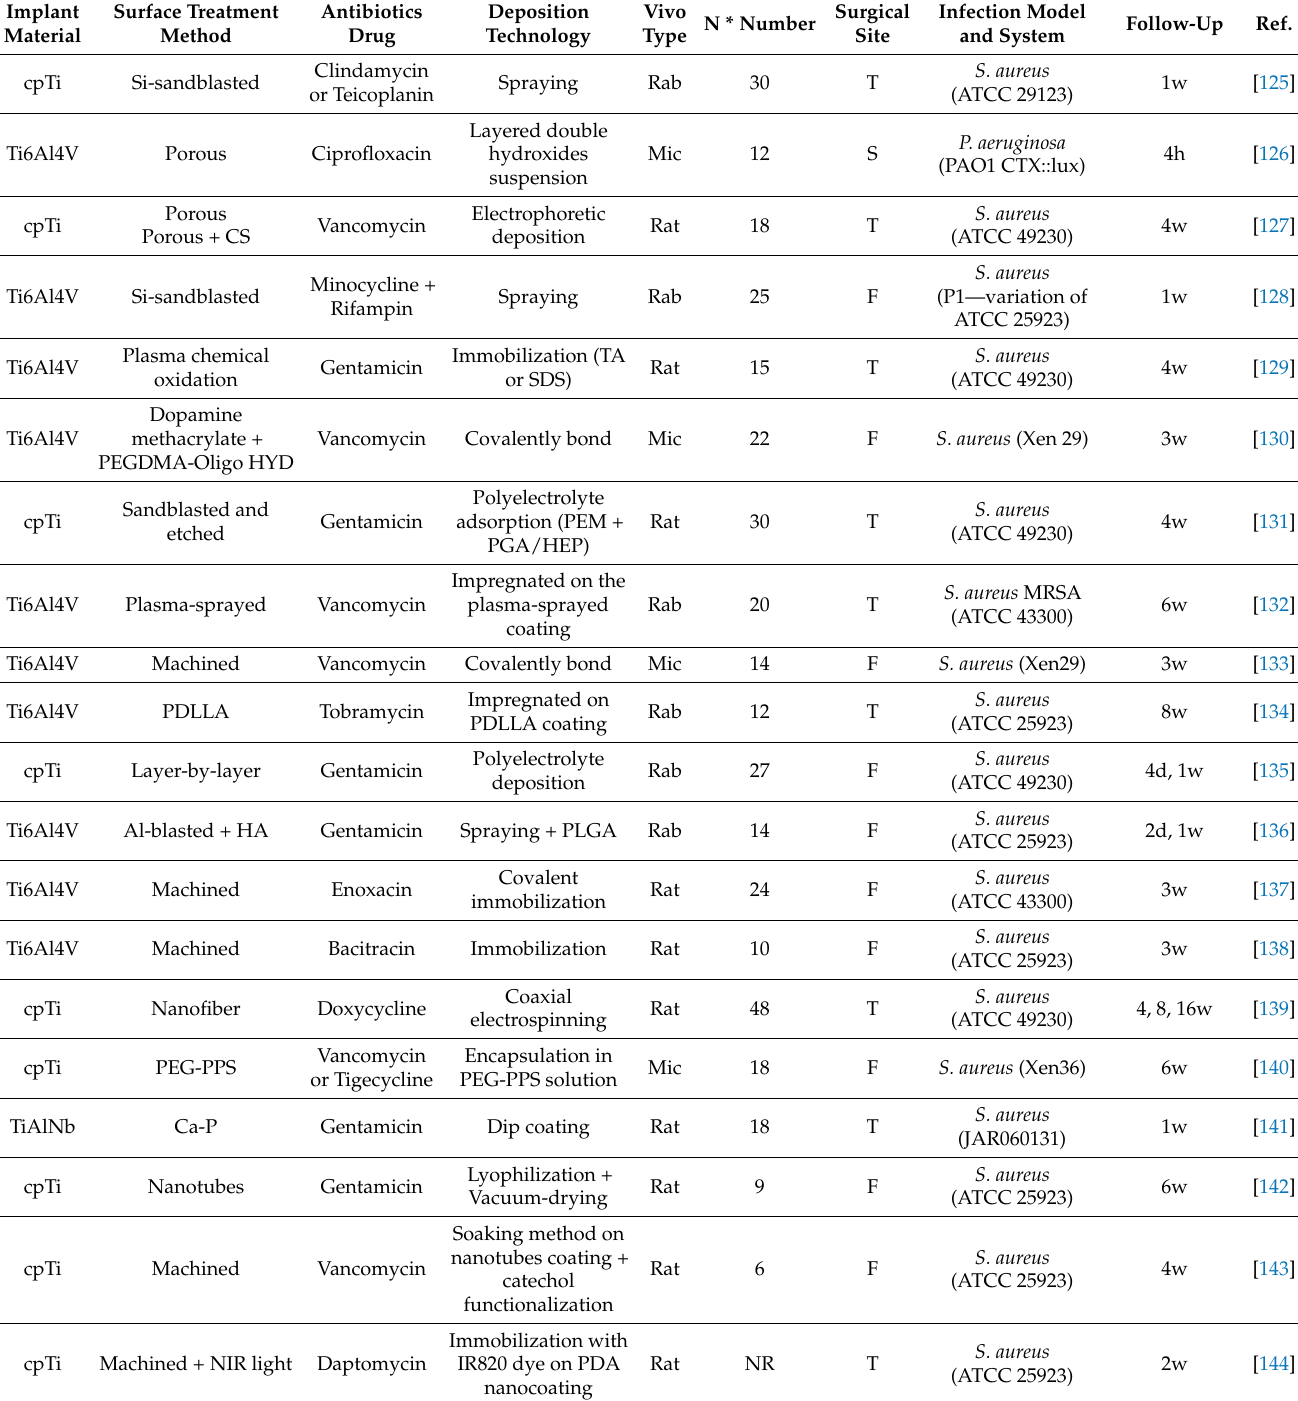
Table notes: Implant surface treatment (TiO 2 , titanium dioxide; Si, Silica; CS, chitosan; PEGDMA, polyethylene glycol dimethacrylate; Oligo, oligonucleotide; HYD, hydrogel; HA, hydroxyapatite; PLLA, poly-L-Lactide; PDLLA, poly(D,L-lactide); NIR, near-infrared light; PLEX, polymer-lipid encapsulation matrix; Al, aluminum; PEG, poly(ethylene glycol); PPS, poly(propylene sulfide); Ca-P, calcium and phosphorus). Deposition technology (TA, tannic acid; SDS, sodium dodecyl sulfate; PEM, polyelectrolyte multilayer; PL, polycation; PGA, polyanion; HEP, heparin; PH, phosphatidylcholine; NR, not reported; PDLLA, poly(D,L-lactide); PEG, polyethylene glycol; MoS2, molybdenum disulfide; CS, chitosan; PLGA, poly(lactic-co-glycolic acid); PPS, poly(propylene sulfide); PDA, polydopamine); Animals (Rat, rats; Mic, mice; Rab, rabbits), Sample number (N) (MRSA, methicillin- resistant S. aureus ; MSSA, methicillin-sensitive S. aureus ; NR, not reported), Surgical site (T, tibia; F, femur; S, subcutaneous; H, humerus; R, radius), Follow-up (h, hour; d, day; w, week). ∗ Sample number reported is the total number of infected animals used for microbiological assessments of non-loaded and antibiotic-loaded